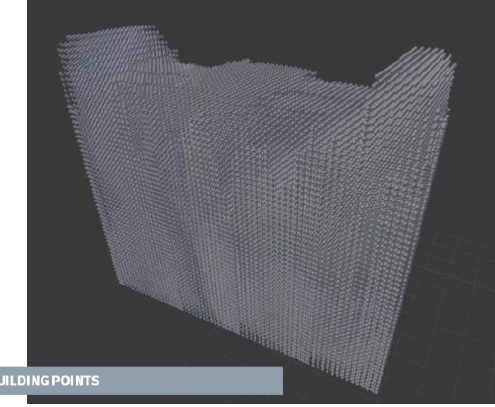
Figure 7. Generated Building Model Screenshot